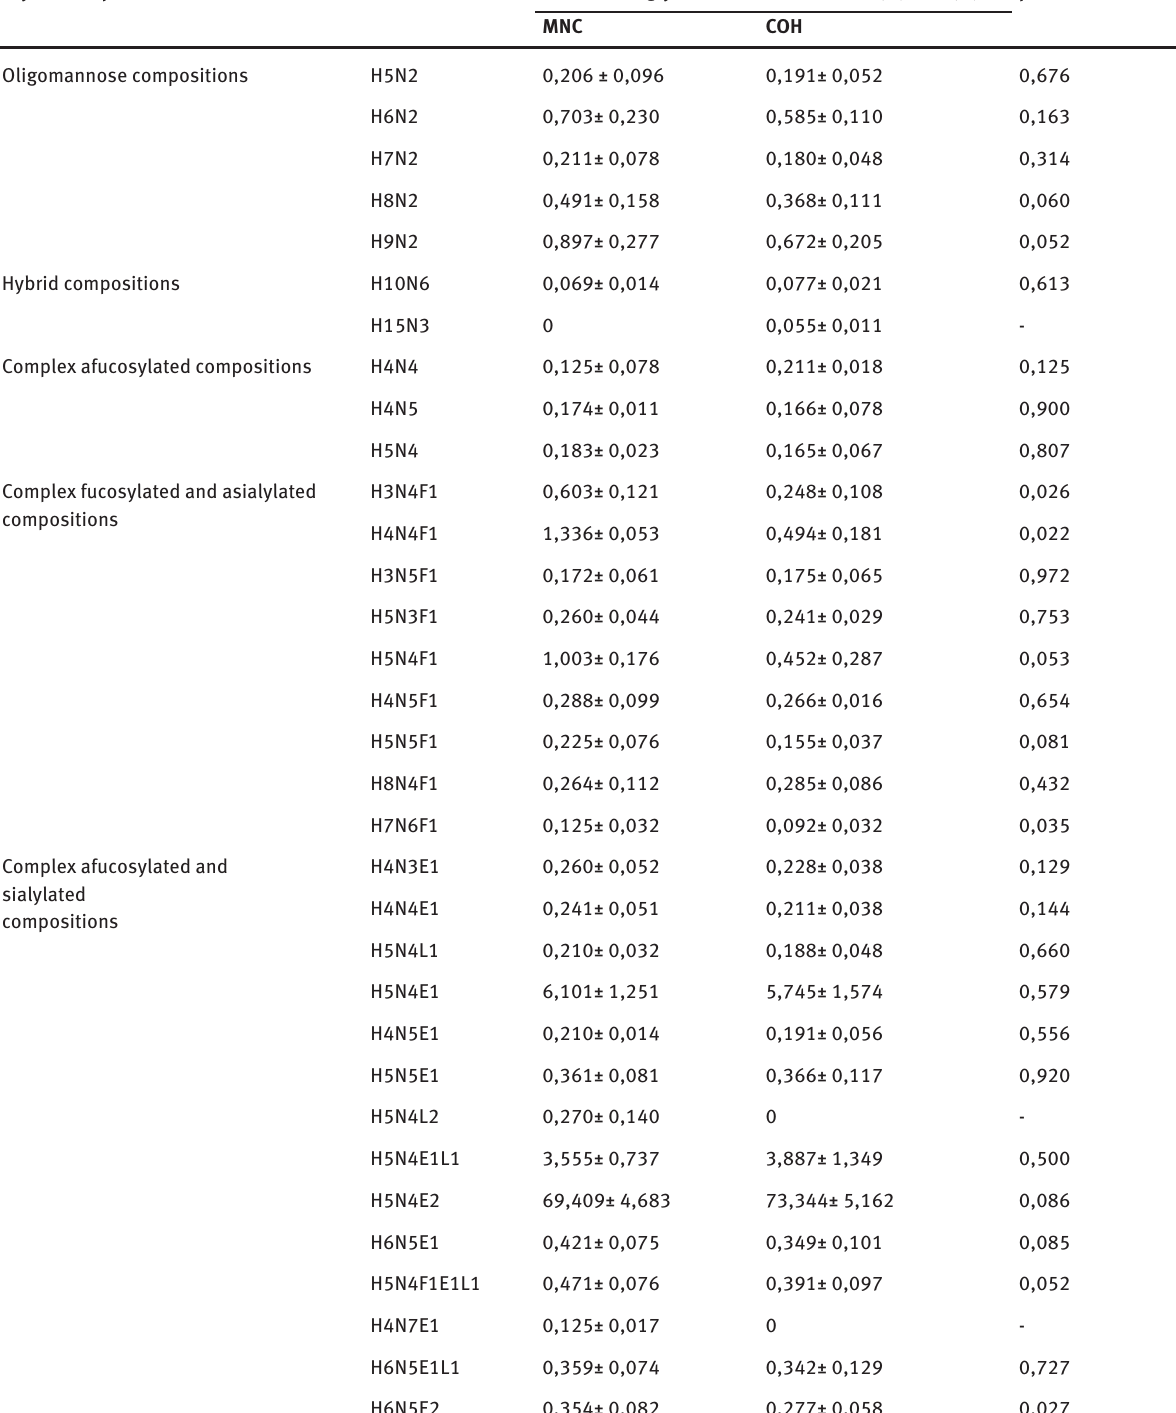
Table 3: The list of identified N-glycan compositions and their normalised relative abundances (expressed as means ±SD; %) in the FFNGs of the MNC and COH groups of patients. The pairwise differences in individual glycans relative abundances between analyzed groups were considered significant at p<0,05 (Mann-Whitney U test). The glycan compositions were assigned and the associated mass errors were calculated by using GlycoMod (29) (http://web.expasy.org/glycomod/) platform with mass tolerance set to 0.2 Da. Abbreviations: H- hexose; natural cycle stimulation protocol; COH- group of patients subjected to GnRH Ant stimulation